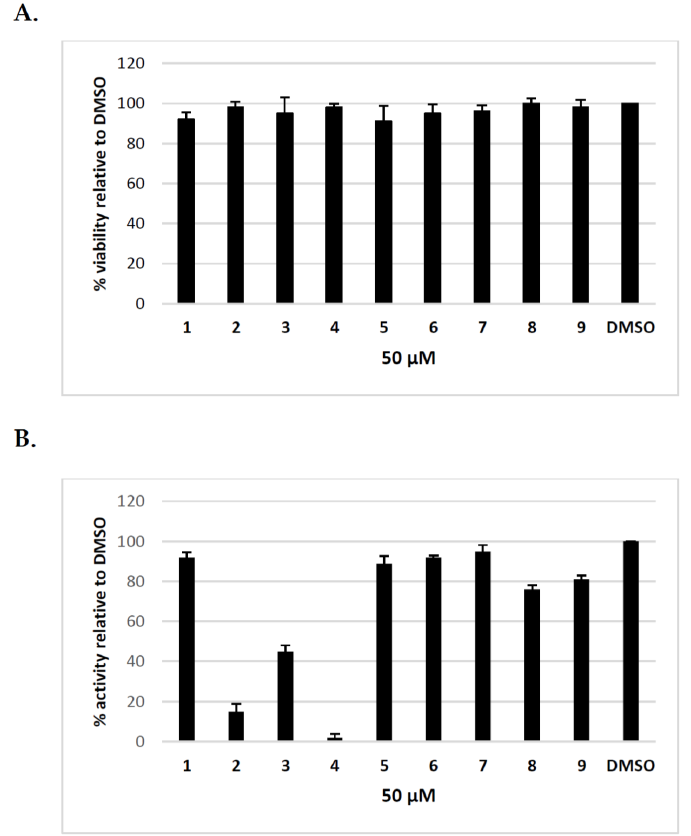
Figure 2. The inhibitory effect of uridine derivatives of 2 ‐ deoxy sugars (compounds 1 – 9 ) against hepatitis C virus. ( A ) Cell viability of Huh ‐ 7.5 cells after treatment for 72 h with compounds 1 – 9 using hepatitis C virus. ( A ) Cell viability of Huh-7.5 cells after treatment for 72 h with compounds 1 – 9 MTS assay; ( B ) The anti ‐ HCVcc antiviral activity of compounds 1 – 9 (50 μ M). Huh ‐ 7.5 cells were using MTS assay; ( B ) The anti-HCVcc antiviral activity of compounds 1 – 9 (50 µ M). Huh-7.5 cells infected with HCVcc at an MOI of 0.1, treated with tested compounds (50 μ M) for 72 h and IPMA